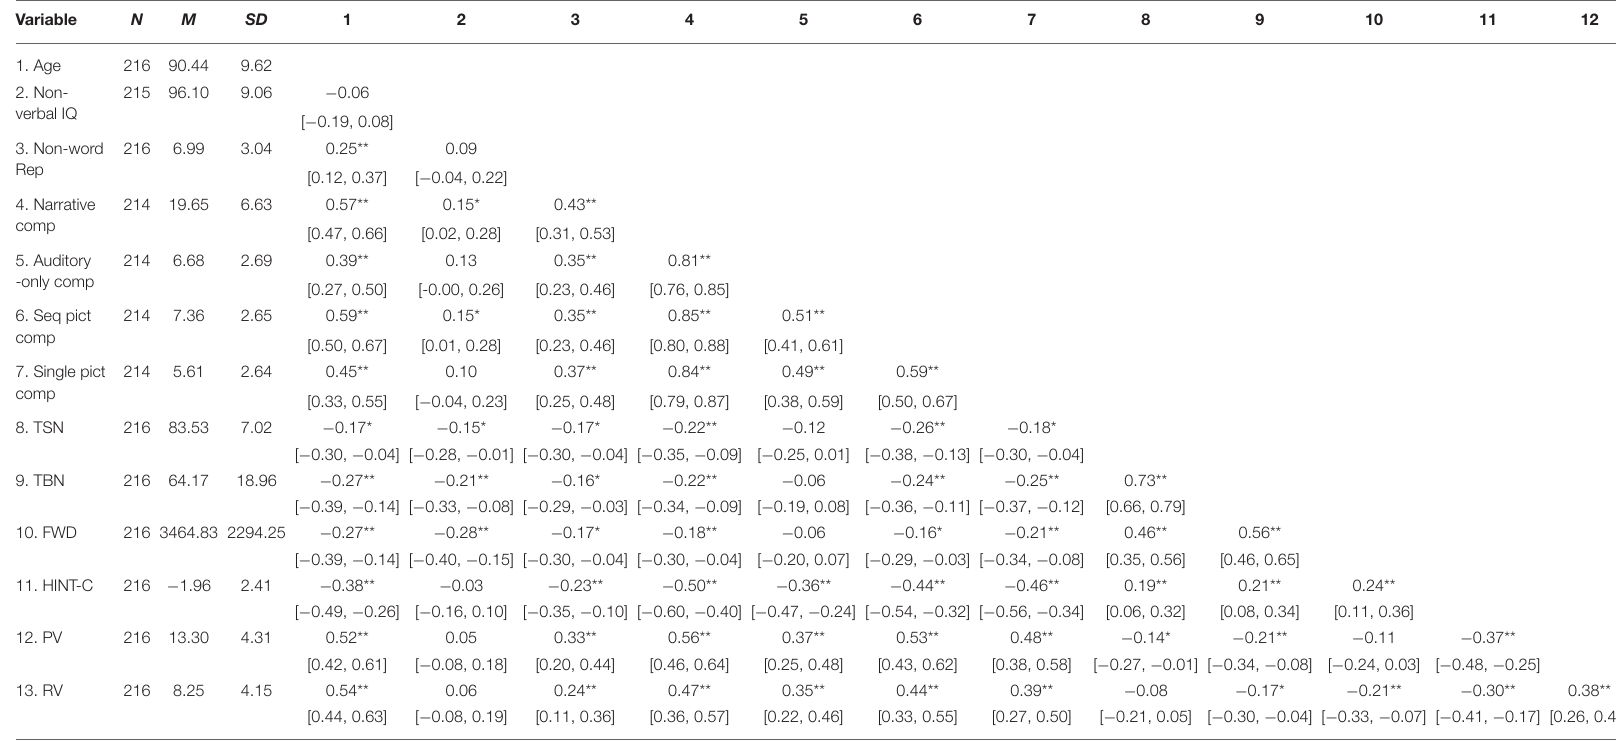
TABLE 2 | Means, standard deviations, and correlations with confidence intervals.